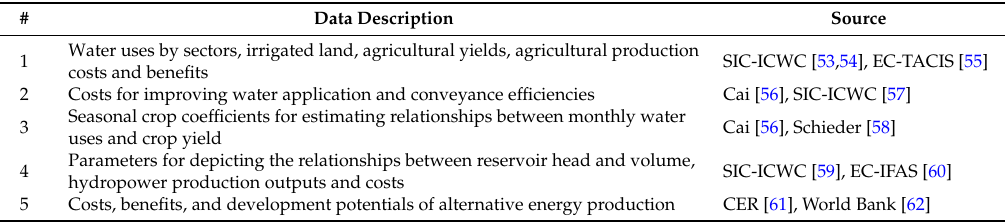
Table 1. Main sources of the SEWEM